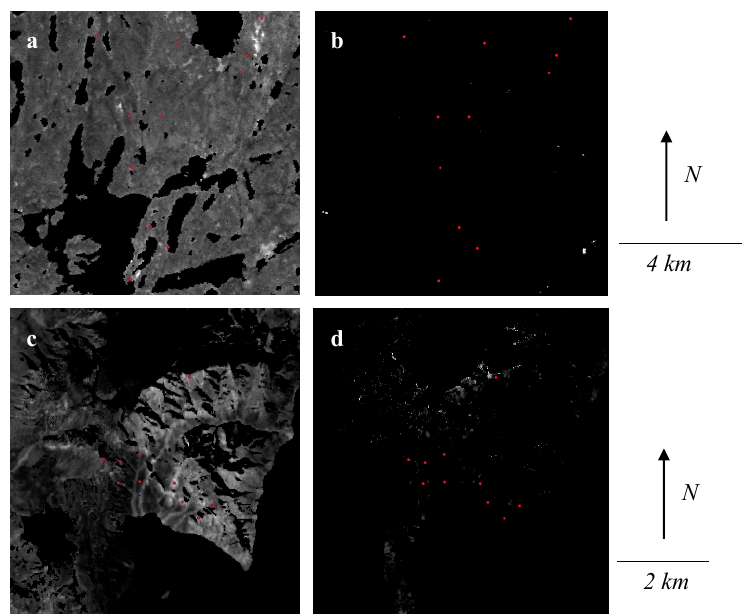
Figure 10. B4 / B2 band ratio ( a ) and IFD ( b ) applied on a part of our cluster 5 (top; long: − 112.2914268; lat: 66.59684054). B4 / B2 band ratio ( c ) and IFD ( d ) applied on a part of our cluster 6 (Bottom; long: − 93.5884; lat: 79.3667). The red dots represent the known gossans locations. For the band ratio and the IFD, the brightest pixels should have highlighted the gossans.